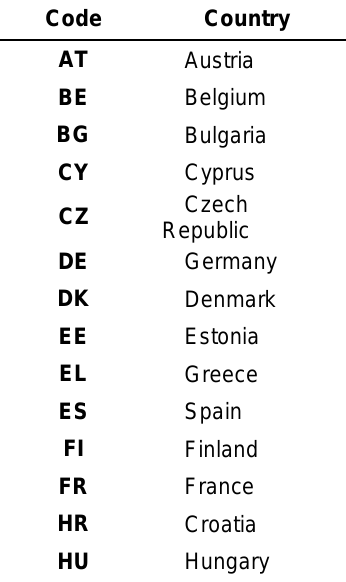
Table A.1. ISO codes for each EU country .